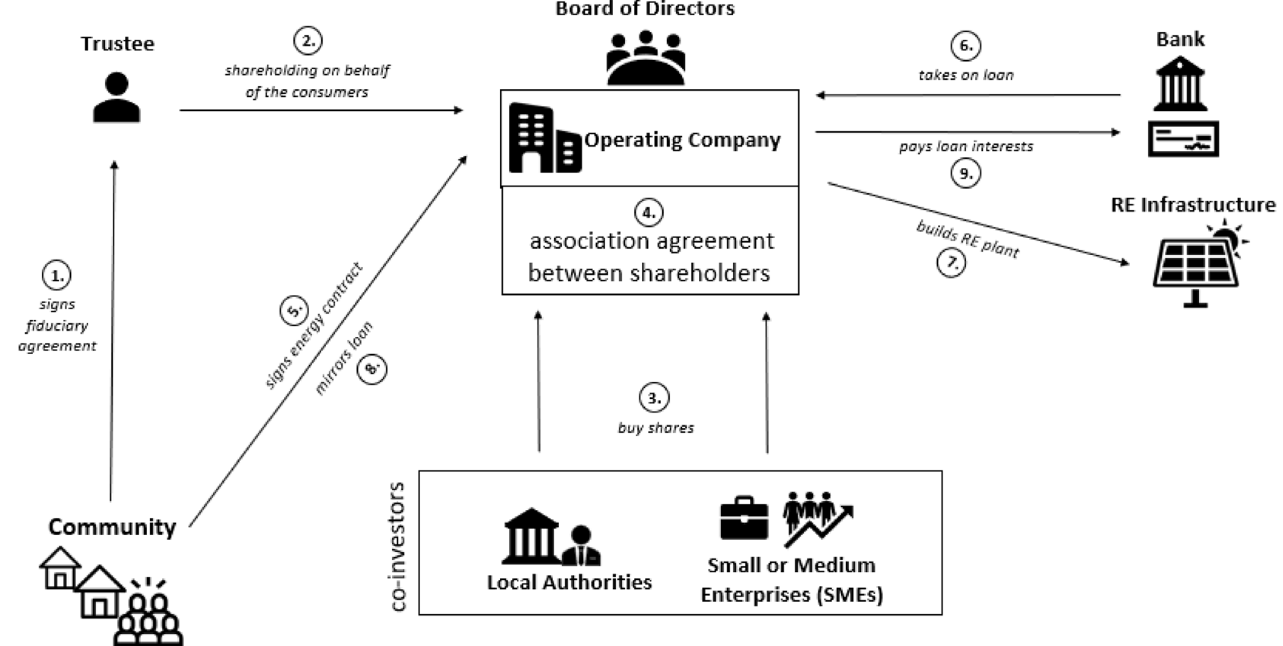
Fig. 1. CSOP structure and organisation (own fi gure based on Lowitzsch